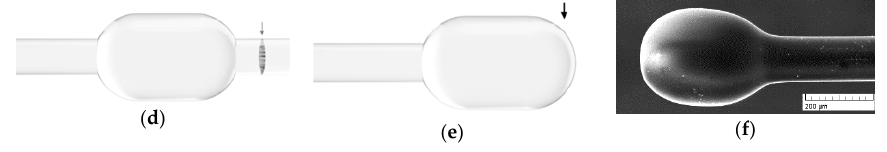
Figure 1. Stadium resonator: ( a – e ) schematic of its fabrication; dark arrows represent electric arcs, while a light arrow represents a cleave; ( f ) scanning electron microscopy (SEM) imaging.